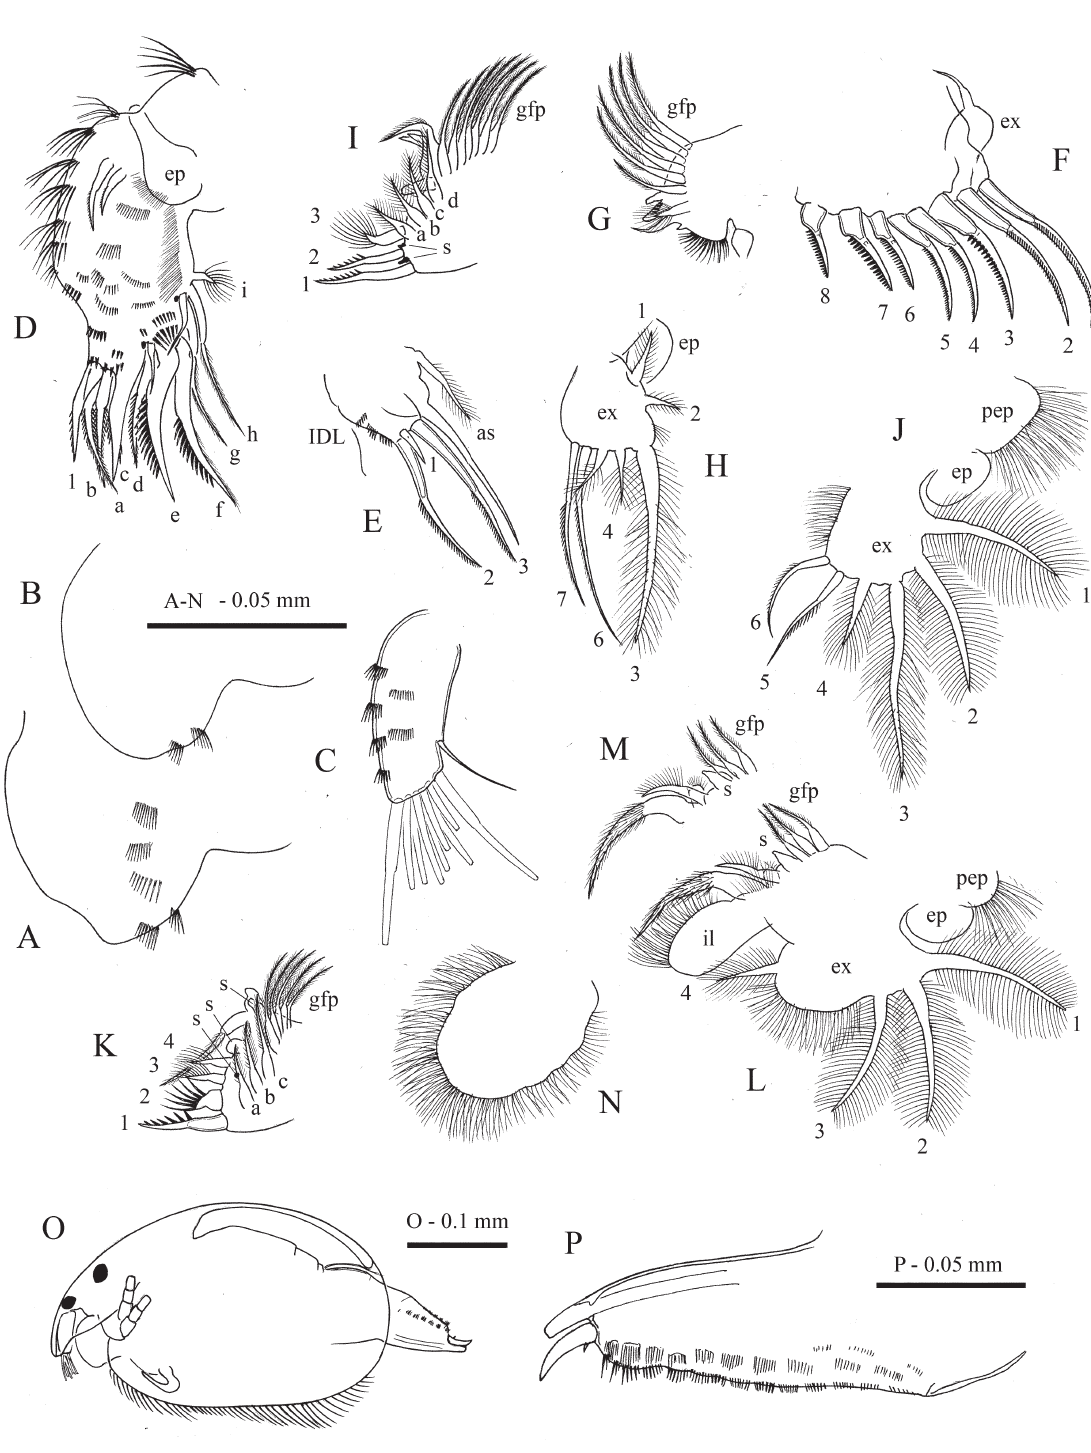
Fig. 5. Flavalona rustica (Scott, 1895) comb. nov. A–N . Labrum, antennule and thoraciс limbs of parthenogenetic ♀ from Bol’shoe Torfyanoe lake, Bolshoi Solovetskiy Island (White Sea), Russia. A–B . Labrum. C . Antennule. D . Limb I. E . IDL and ODL of limb I. F . Scrapers of limb II. G . Gnathobase of limb II. H . Exopodite of limb III. I . Inner portion of limb III. J . Exopodite of limb IV. K . Inner portion of limb IV. L . Limb V. M . Gnathobase of limb V. N . Limb VI. O–P . Adult ♂. O . Lateral view. P . Postabdomen. Figure O redrawn from Alonso (1996) and P from Sinev